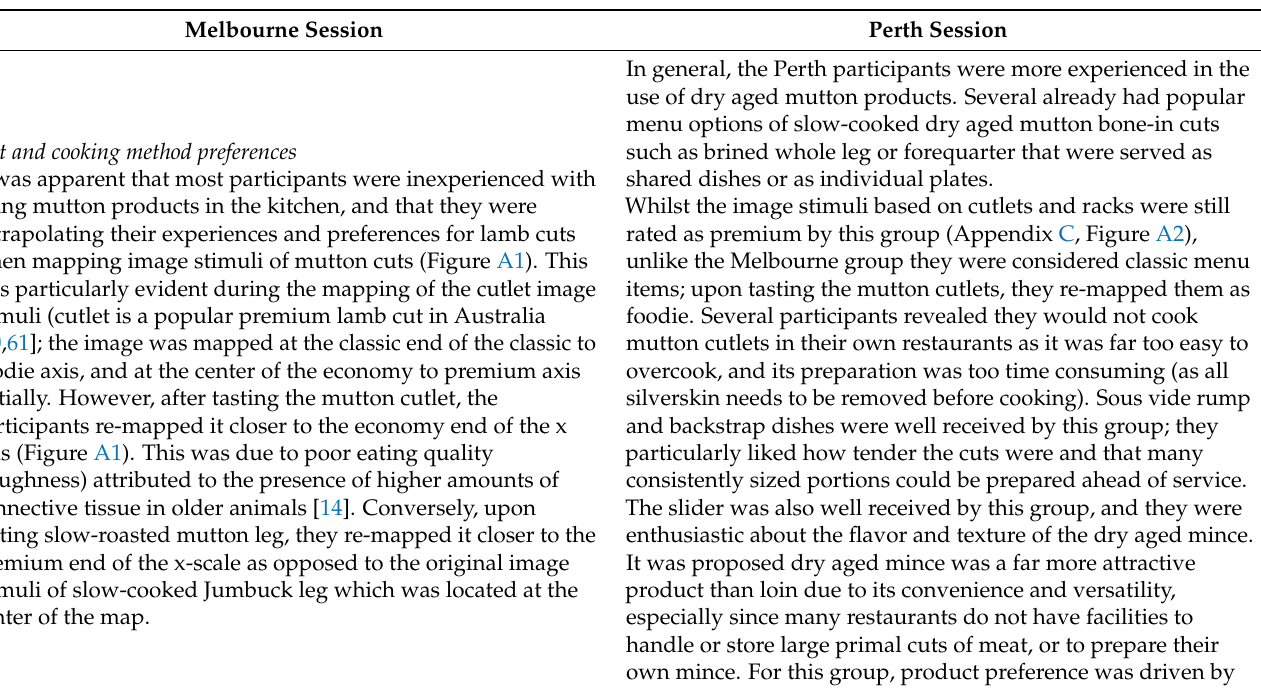
Table A3. Perceptual mapping results for Melbourne and Perth